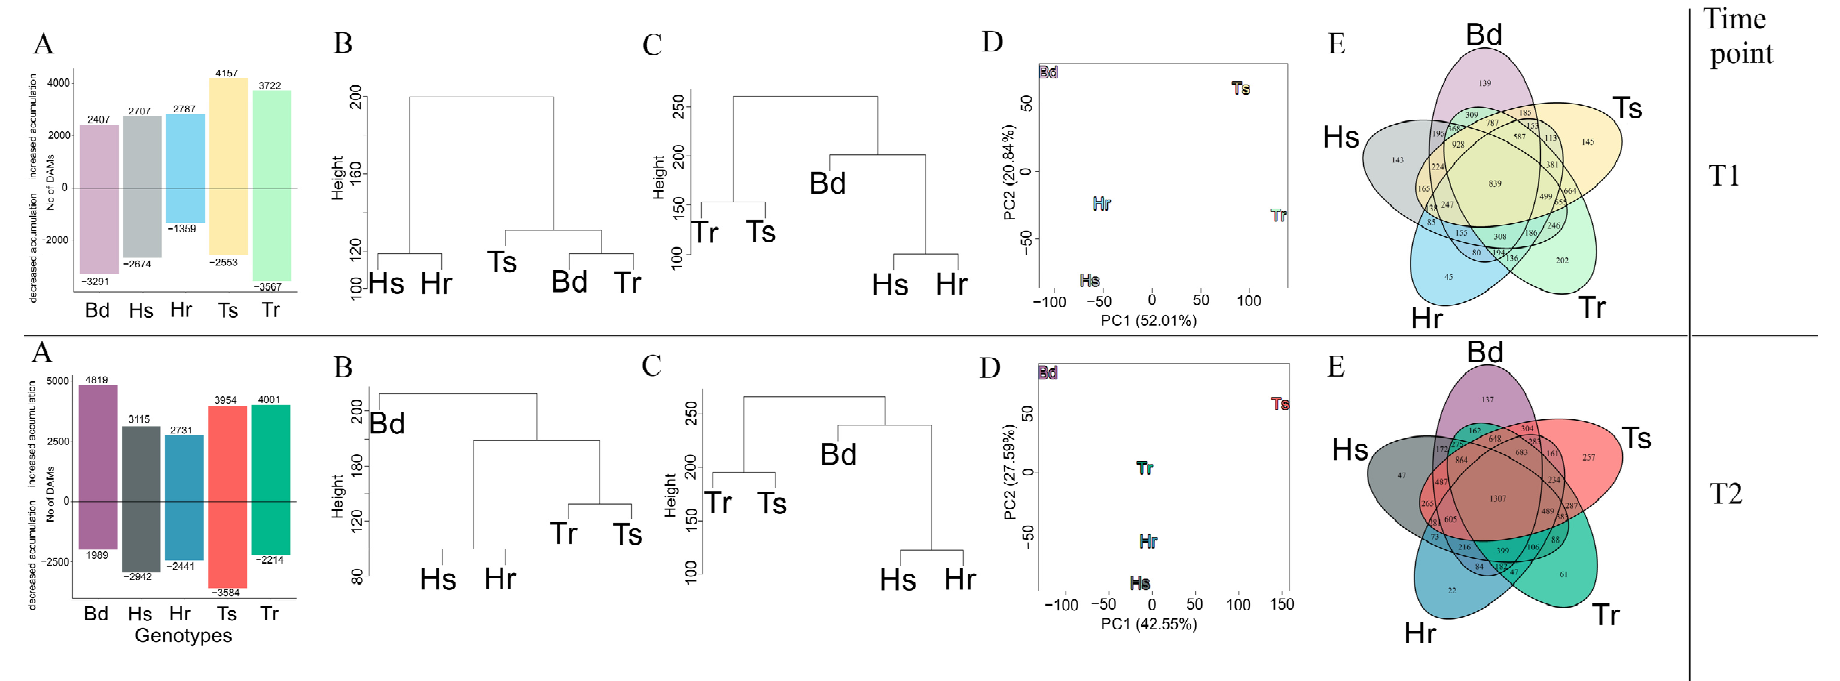
Figure 2. Characterization of global metabolomic changes in studied genotypes in response to F. culmorum. Upper panel representing results for time point T1 and bottom panel representing results for time point T2 ( A ) Bar charts presenting number of DAMs selected after ANOVA with q-value <0.05 and fold-change (FC) between inoculated and control group |log2FC| > 0.58 with increased or decreased accumulation after F. culmorum inoculation in each genotype, ( B ) hierarchical clustering of metabolomic profile for control plants on the basis of Euclidean distance and complete link grouping algorithm, ( C ) hierarchical clustering of metabolomic profile for group of plants infected with F. culmorum , ( D ) PCAs of DAMs for studied genotypes, ( E ) Venn diagrams presenting number of shared and unique DAMs for studied genotypes. Symbol “Bd” is for Brachypodium distachyon Bd21 line, ”Hs” is for Hordeum vulgare FHB—susceptible genotype, “Hr” is for Hordeum vulgare FHB—resistant genotype, “Ts” is for Triticum aestivum FHB—susceptible genotype and “Tr” is for Triticum aestivum FHB—resistant genotype